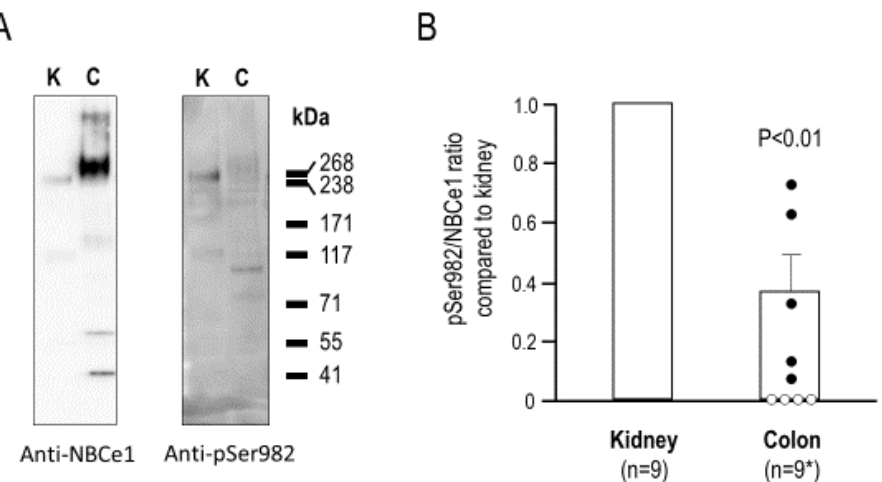
Figure 3. Probing the pSer982 status of kidney and colon NBCe1. ( A ) Western blot showing anti- NBCe1 immunoreactivity and anti-pSer982 immunoreactivity in protein lysates from murine kidney (2 µ g/lane) or colon (10 µ g/lane); ( B ) Quantification of the ratio of pSer982/NBCe1 in colon versus kidney. Open circles represented null data points due to undetectable pSer982 immunoreactivity in colon and were excluded from the statistical analysis shown.